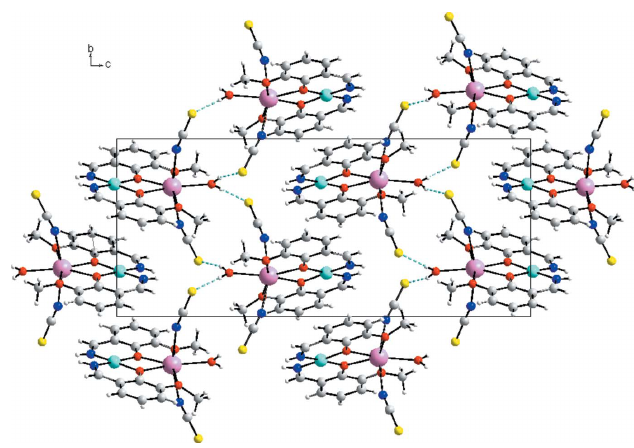
Figure 5 Packing diagram of the title compound viewed along the a axis, showing the supramolecular chains. The dashed lines denote hydrogen bonds.